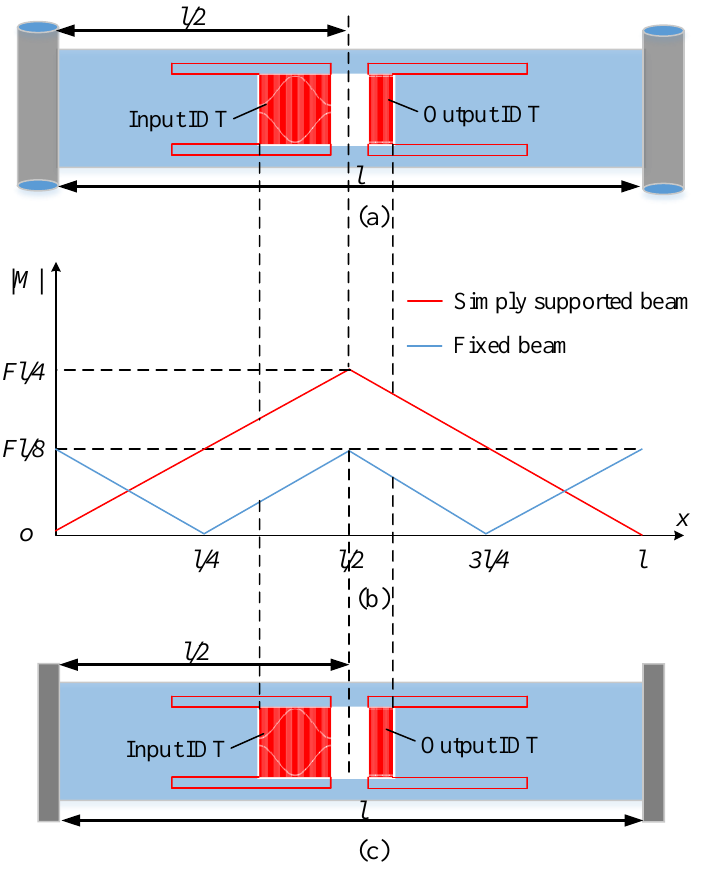
Figure 7. The analysis results of sensitivity optimization based on the elastic beam theory: ( a ) structure diagram of the piezoelectric substrate of the simply supported beam SAW yarn tension sensor; ( b ) distribution diagram of the absolute value of bending moment; and ( c ) structure diagram of the piezoelectric substrate of the fixed beam SAW yarn tension sensor .